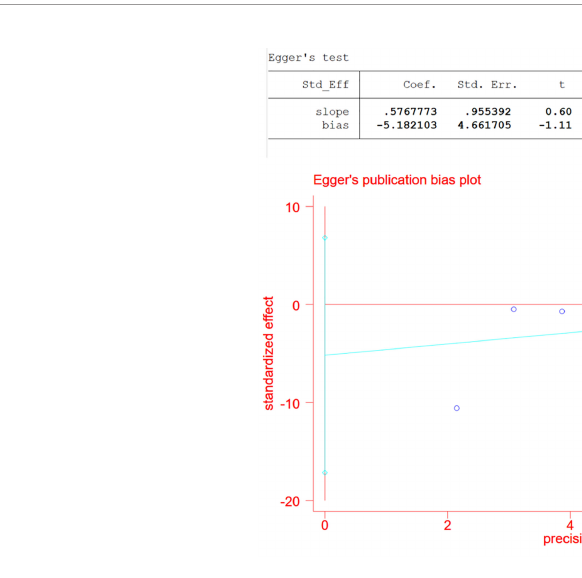
FIGURE 5 | Estimate of publication bias of